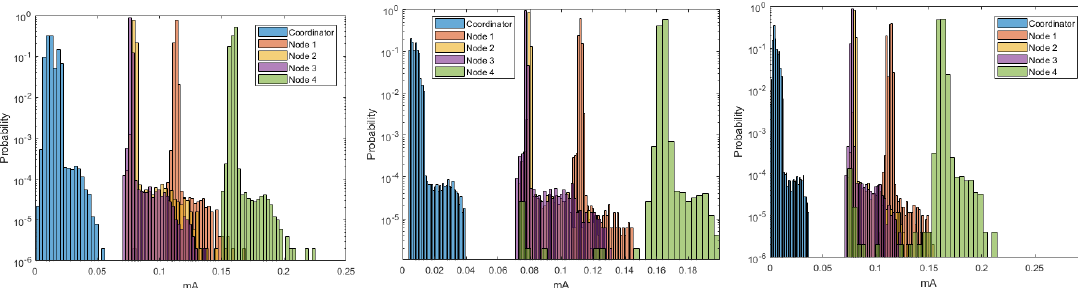
Figure 5. Histograms for DigiMesh network. From left to right: at 9600, 19,200, and 57,600